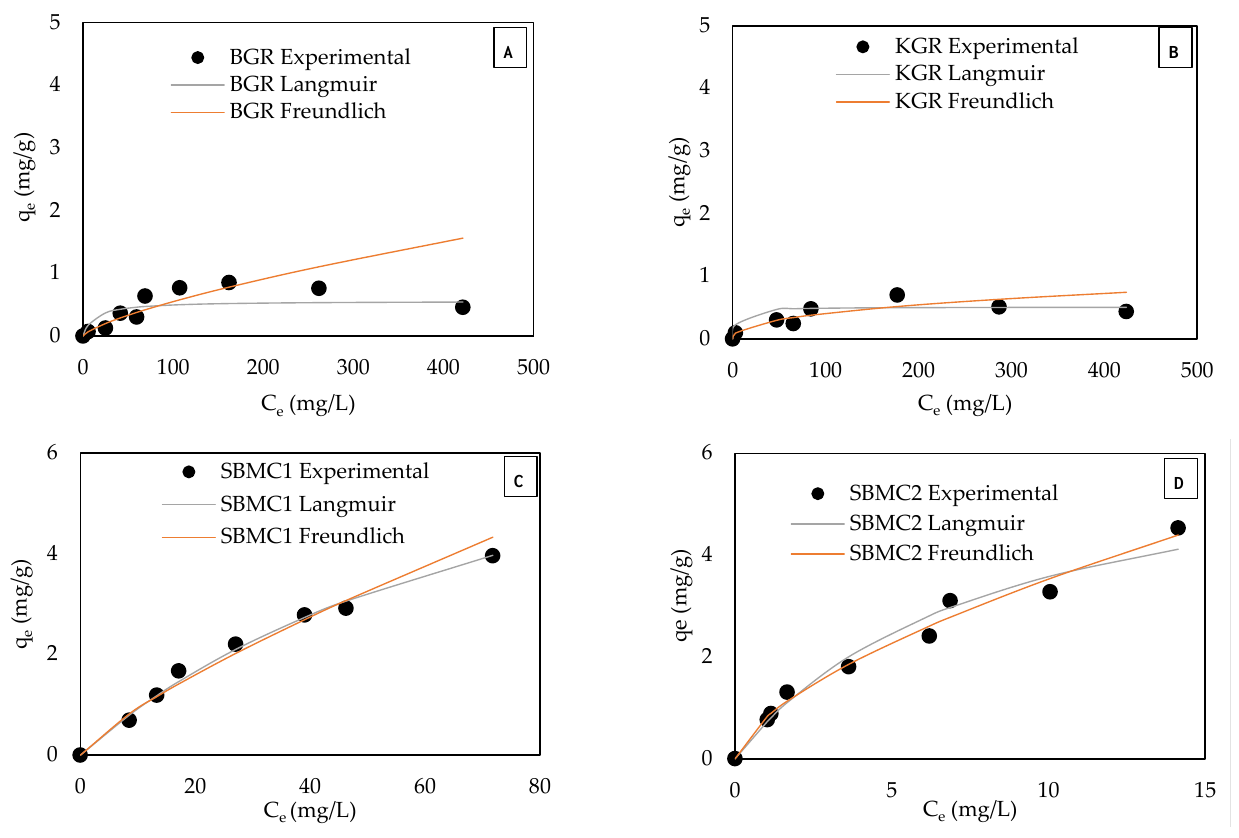
Figure 5. Adsorption data using Linear, Langmuir and Freundlich plots at different concentrations of Cd using granitic residual soil, ( A ) BGR, ( B ) KGR and marine clay ( C ) SBMC1, ( D ) SBMC2. Table 3. Adsorption isotherms and their